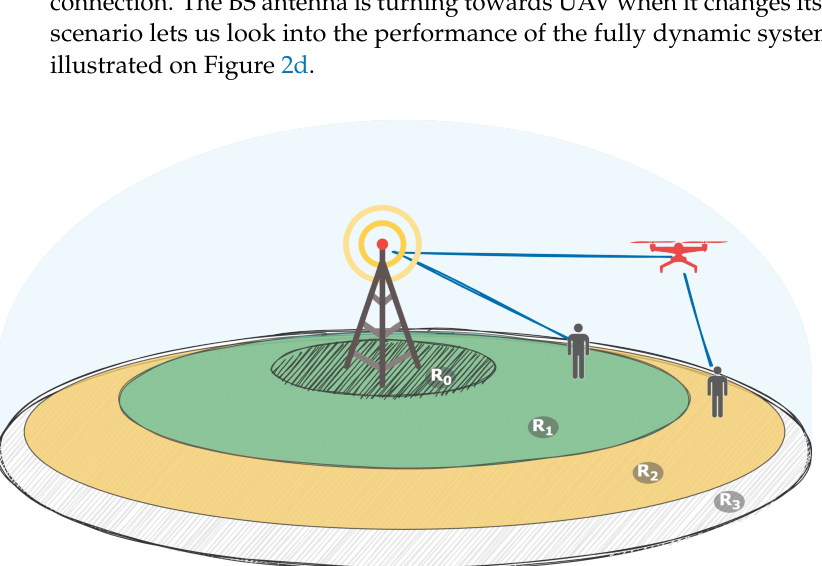
Figure 1. Base station and its coverage areas, divided into four areas, R 0 , R 1 , R 2 and R 3 , correspond- ing to the inner, BS coverage, middle and outer areas. The inner area is restricted to UAVs since the BS antenna would not be able to catch up to them and depends on the maximum allowed UAV speed. The BS coverage area corresponds to the area where users are directly connected to the BS. The middle area is the area where UAVs can have a stable link to the BS and together with the inner area and BS coverage area completes the overall coverage of the BS directional antenna. The outer area corresponds to the BS coverage extension provided by utilizing UAVs as